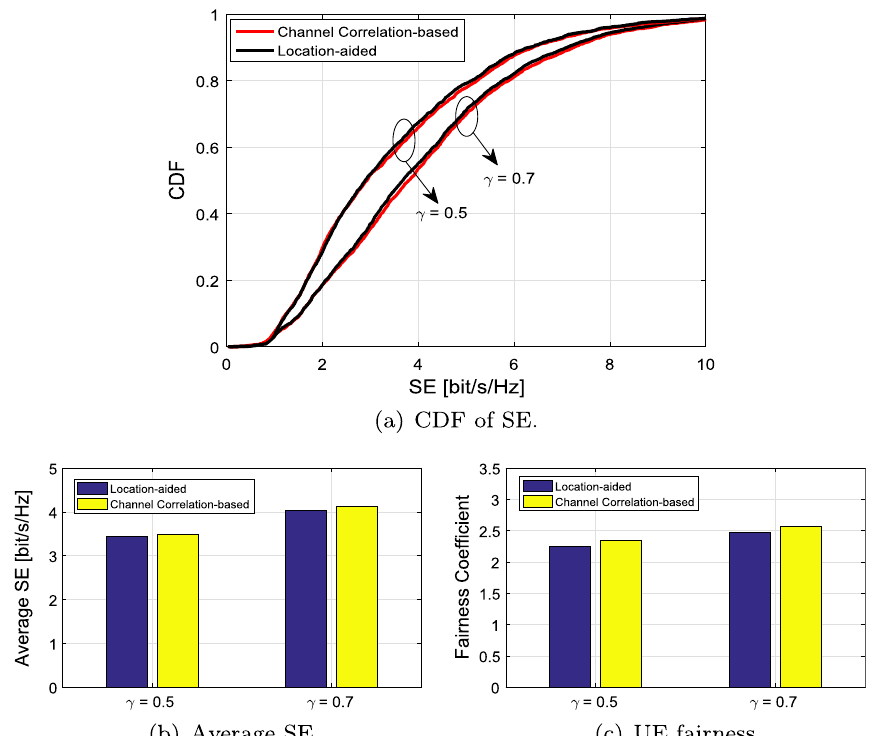
Fig. 4 The comparison of per-UE uplink SE, average SE and UE fairness of the proposed combining scheme with the channel correlation-based combining under different thresholds γ , where M τ p = 5, and γ = 0.5 and